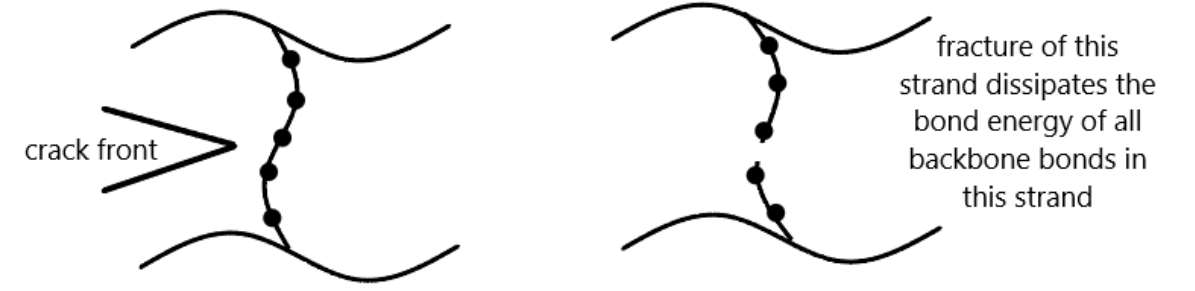
Figure 1. Schematic of Lake–Thomas theory. The black dots represent the carbon atoms, while the lines connecting two adjacent black dots represent the carbon–carbon bonds in the polymer strand. When the crack propagates and breaks one carbon–carbon bond, the bond energy of all backbone bonds will be dissipated. The fracture toughness of the broken strand is enhanced by the number of backbone bonds in the strand.